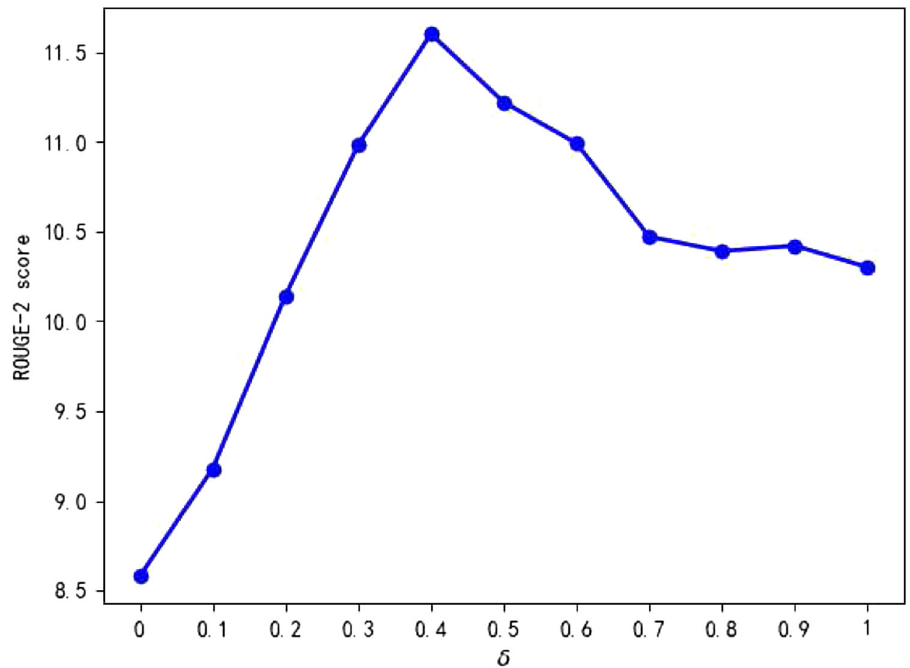
Fig. 3 ROUGE-2 scores vs. δ on the test set